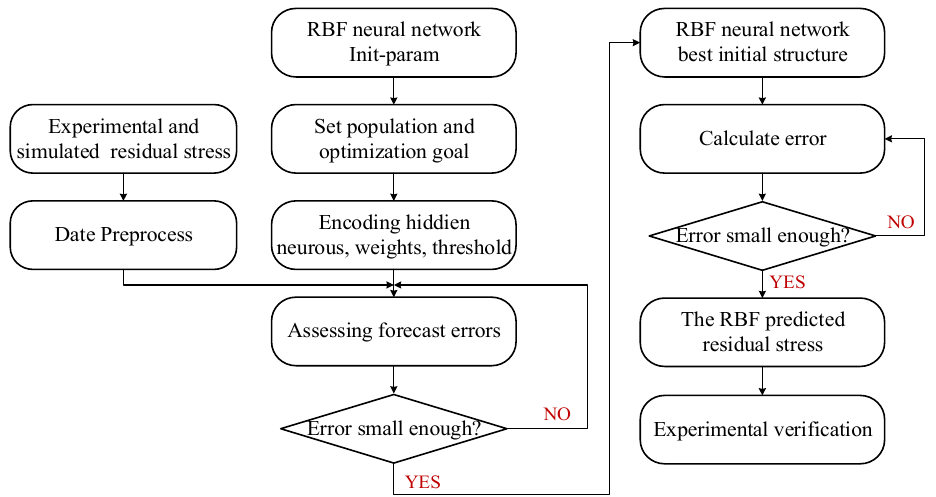
Figure 9. Flowchart of the prediction model based on an RBF neural network.